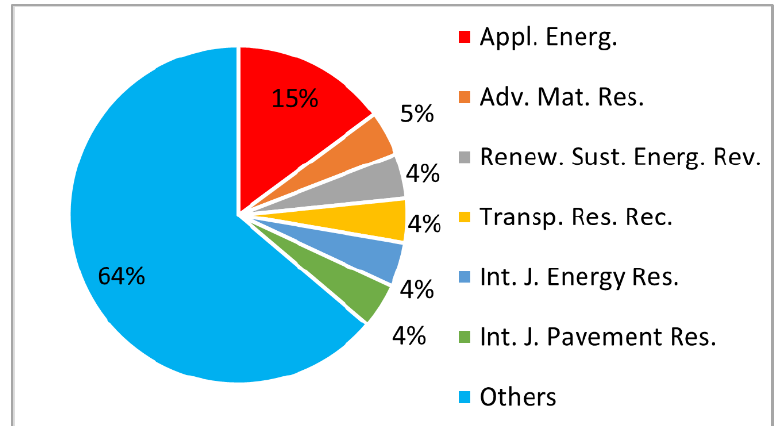
Figure 5. Percentage of articles published per journal.